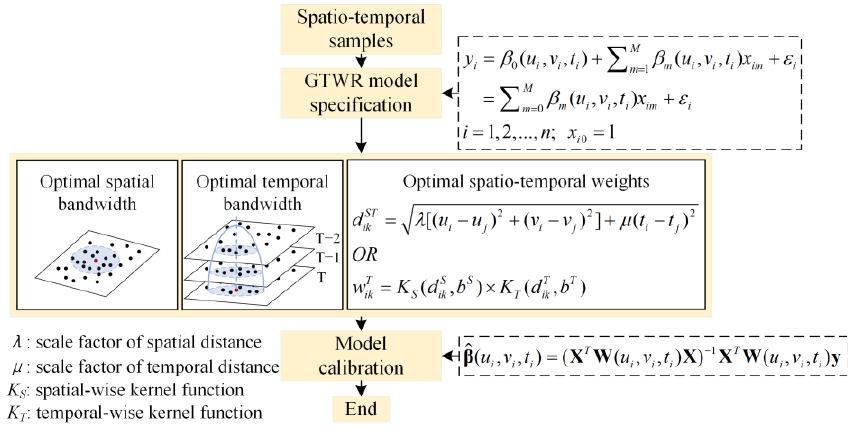
Figure 15. Scheme of GTWR model [70,71].